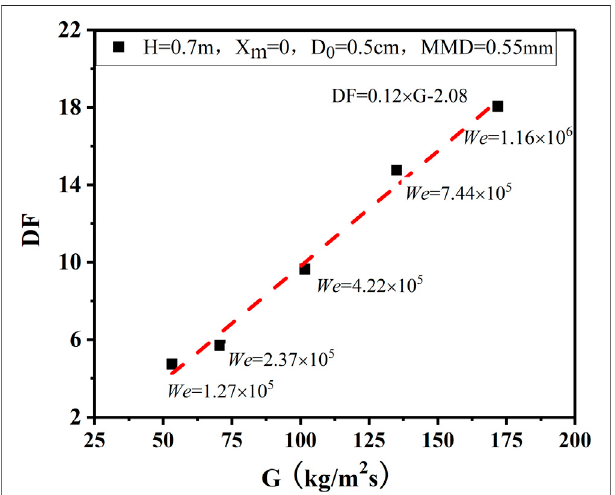
FIGURE10| In fl uenceofmass fl uxonDFwithincondensable gasunder the jet regime.